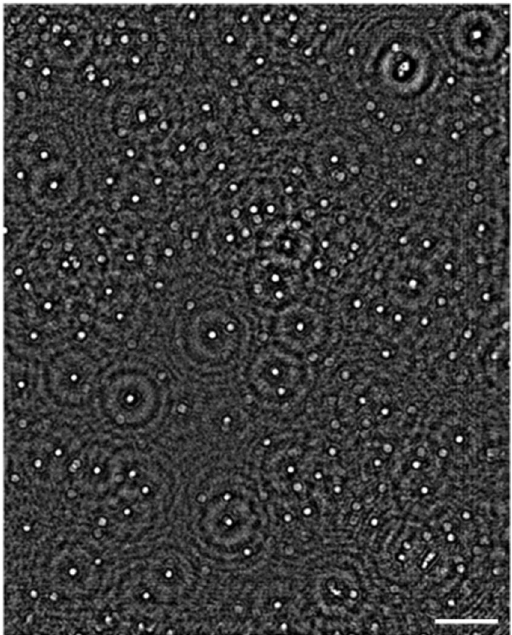
Figure 4. Reconstructed phase image of an HSV-1 sample. Scale bar: 50 µ m.